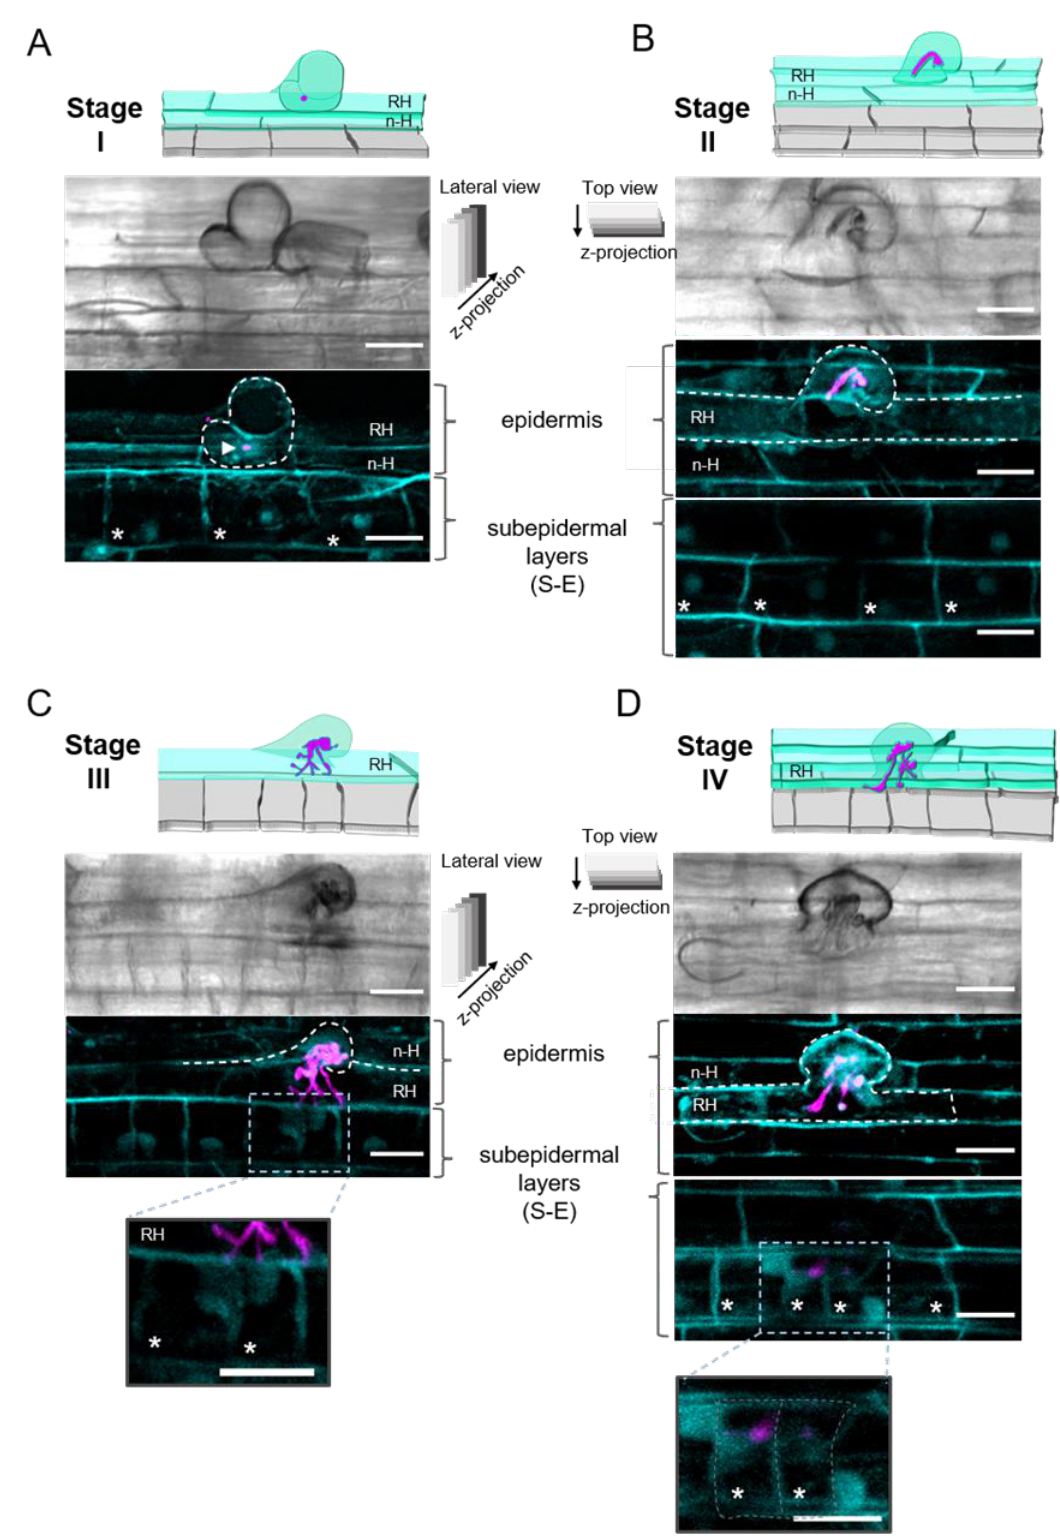
Figure 1. The four stages involved in rhizobia infection in Phaseolus vulgaris roots. Schematic representation and 2D projections of images from the epidermal infection sites (stages I to IV) in P. vulgaris wild-type roots inoculated with R. etli CE3-DsRed pMP604 and harvested at 4 days post-